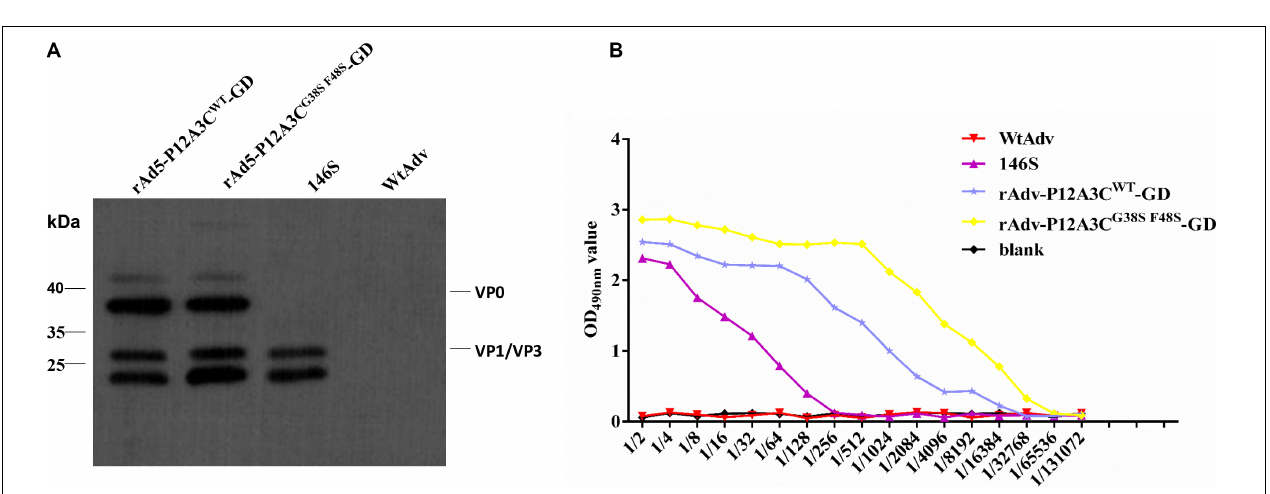
FIGURE 3 | Identification of the recombinant proteins. (A) Western blotting analysis of the recombinant proteins. (B) Antigenicity of the recombinant proteins was tested with IS-ELISAs.